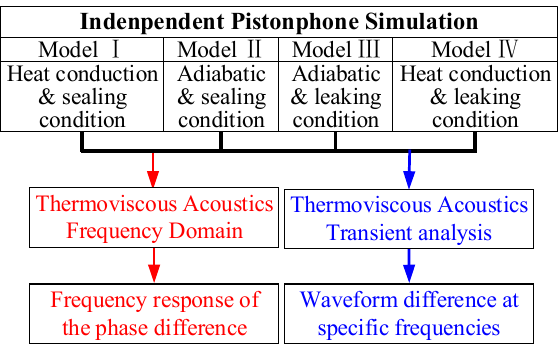
Figure 3. Flow chart of the pistonphone simulation.